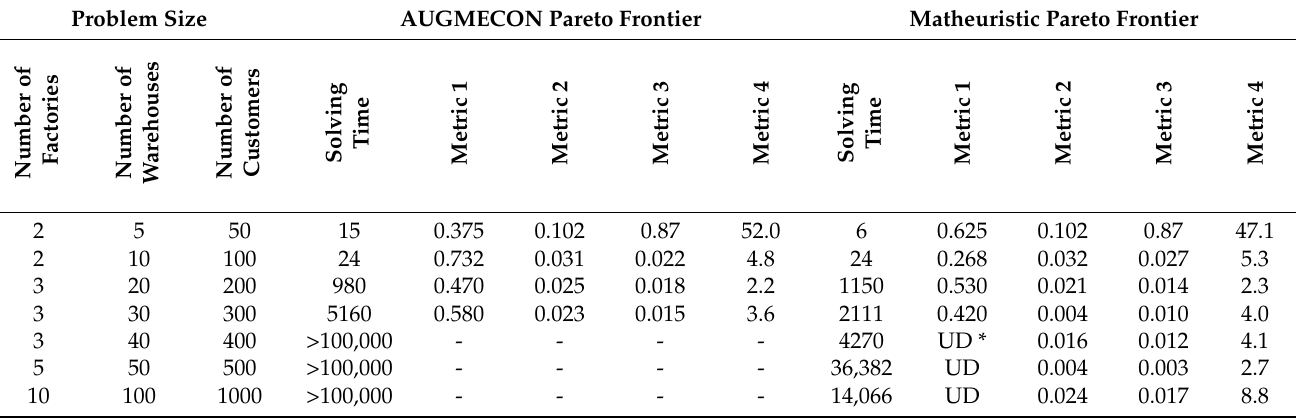
Table 2. Solving time comparison for the AUGMECON and matheuristic